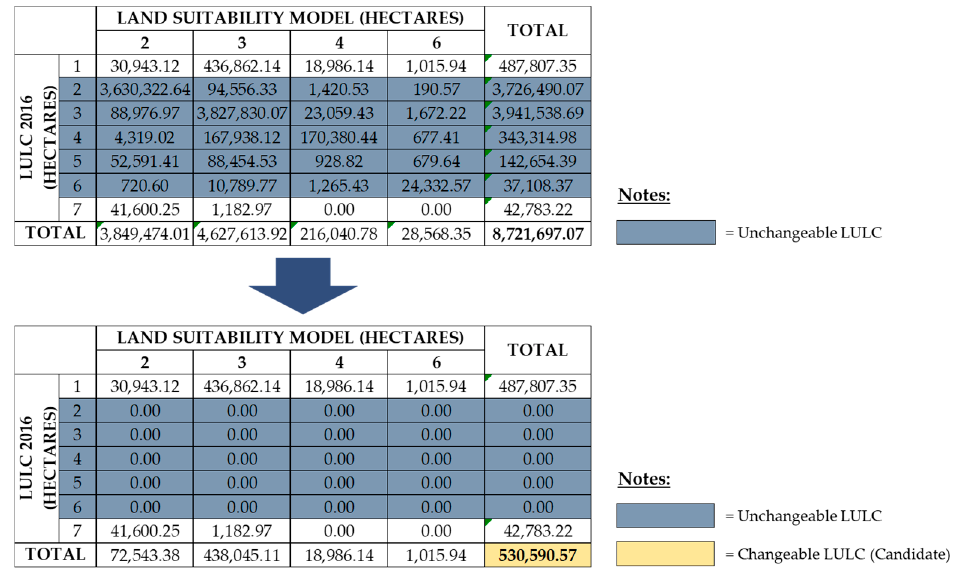
Figure 11. The total area of changeable or possible candidate of the deficit land-use/land cover(s) (LULC). Table 12. The possible allocation fulfillment of land-use/land cover in Java Island based on the land suitability. LULC Type Supply * Forest